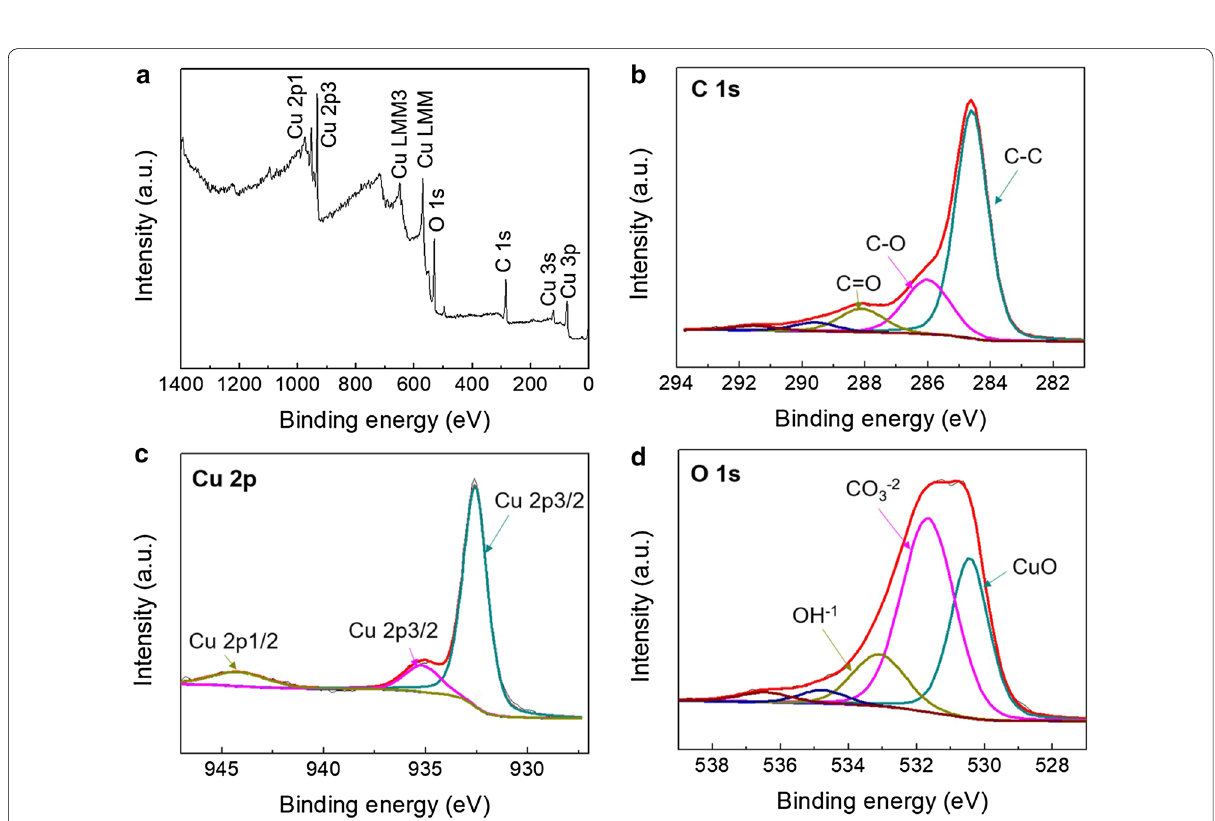
Fig. 4 XPS analysis a survey scan, b C 1s, c Cu 2p, and d O 1s for the CuO–GO nanocomposite